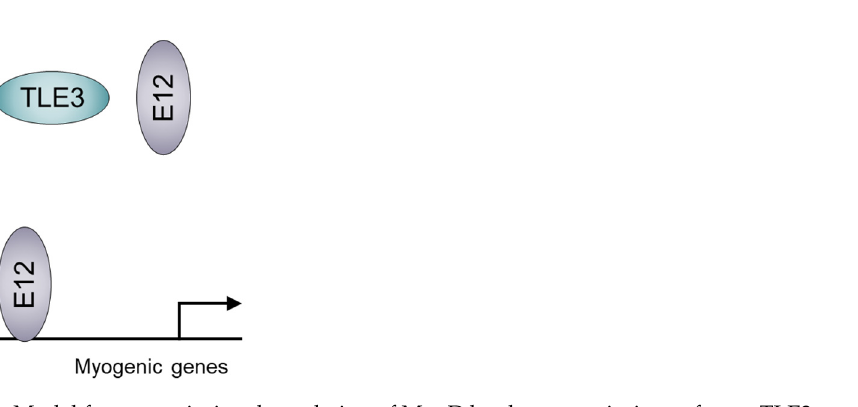
Figure 4. Model for transcriptional regulation of MyoD by the transcription cofactor, TLE3.